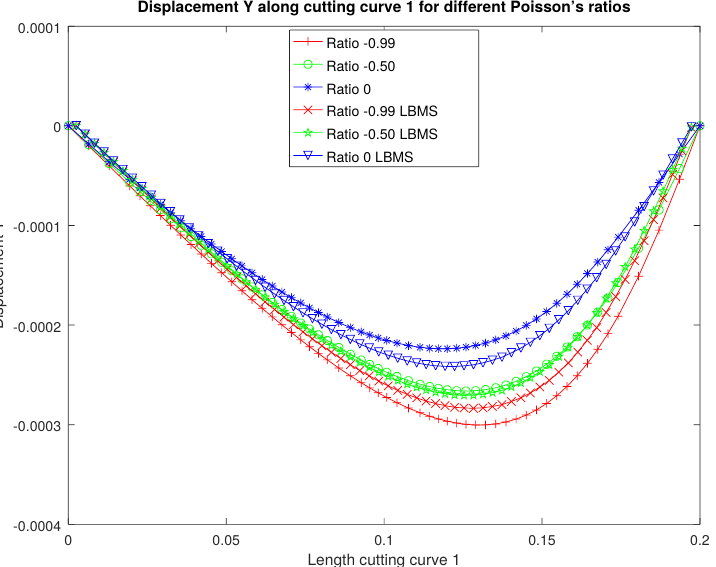
Figure 5. Second displacement components along cutting curve C 1 for negative Poisson’s ratios. The results shown are acceptable in terms of matching with the reference